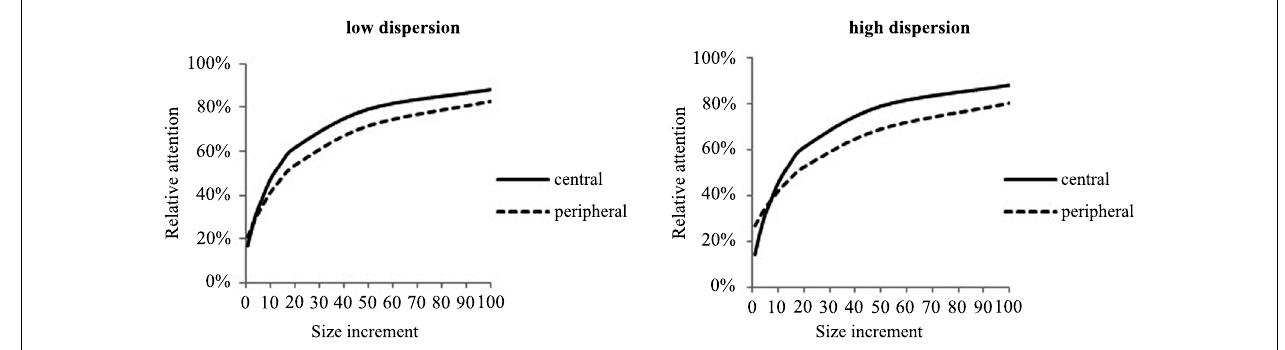
FIGURE 2 | Effects of size on attention for central and peripheral objects under low and high dispersion of objects.